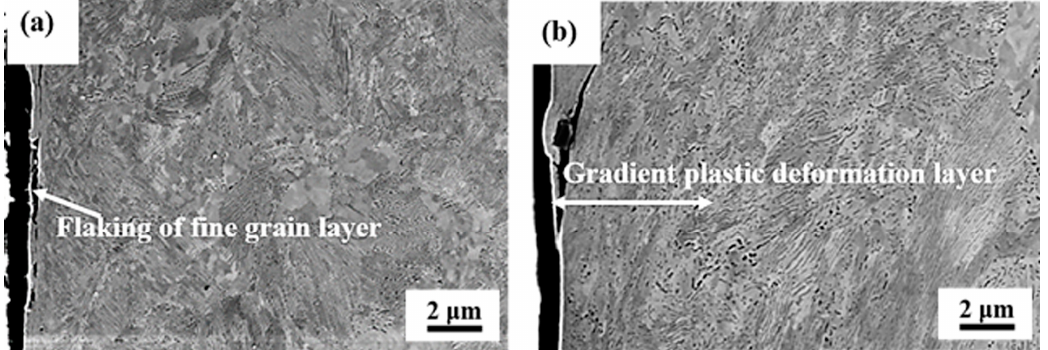
Figure 9. The SEM micrographs of the microstructural evolution of samples after RCF failure: ( a ) the grinding processing sample and ( b ) the sample after SURT with 0.4 MPa.